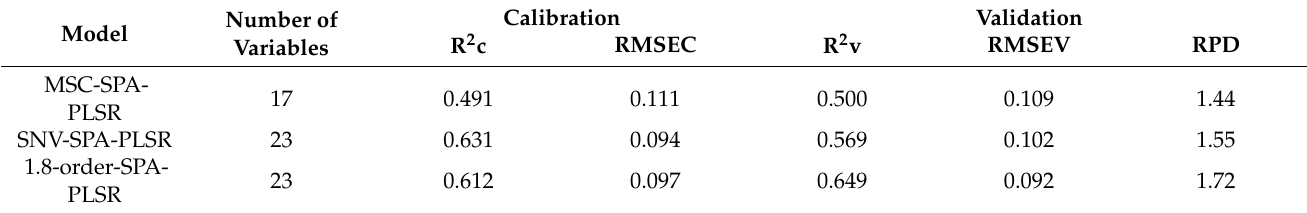
Figure 5. Scatter plots of true and predicted TN content for the calibration and validation set of original, first-order, 1.8-order and second-order derivatives. The red line represents the 1:1 line between the true and predicted TN content. ( a , c , e , g ) are scatter plots of calibration set results; ( b , d ), ( f , h ) are scatter plots of validation set results. Table 4. Modeling results under different